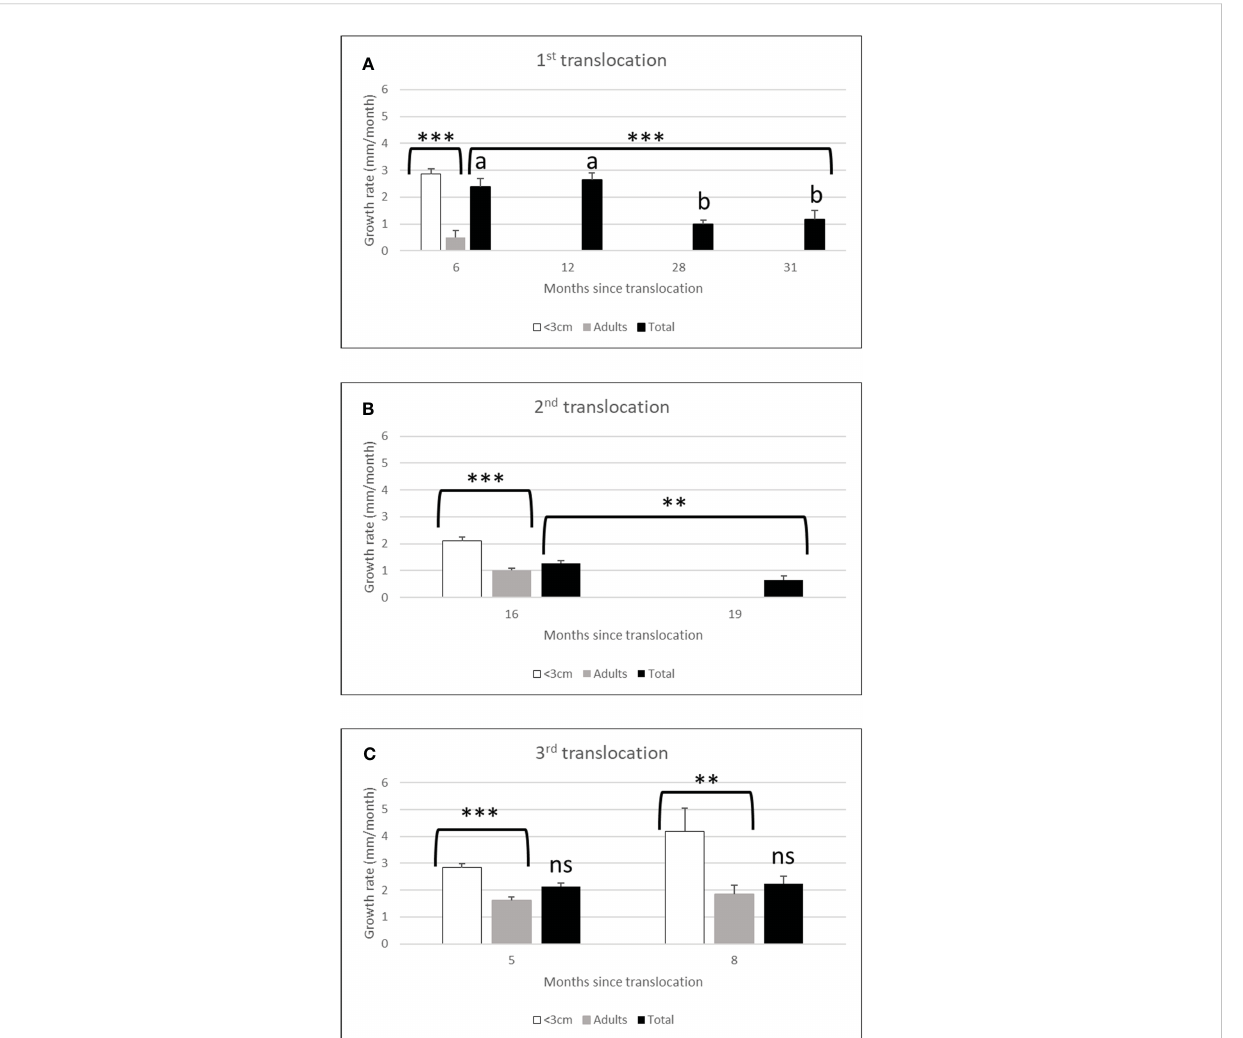
FIGURE 10 Mean growth rates ( ± SE) for recruits (<3cm), adults, and the total individuals translocated for each of the translocation events. (A) : fi rst translocation (Oct. 2018). ***p<0.001 (ANOVA test). Letters indicate homogeneous groups according to a posteriori SNK test; (B) : second translocation (Oct. 2019). ***p<0.001, **p<0.01 (ANOVA test); and (C) third translocation (Sep. 2020). ***p<0.001, **p<0.01, ns, not signi fi cant (ANOVA test). Data have been calculated by rating the increase in size (mm) by the months that have passed between time intervals in which size measurements were recorded. The individuals were considered adults if their size was greater than 3 cm at the beginning of the calculated